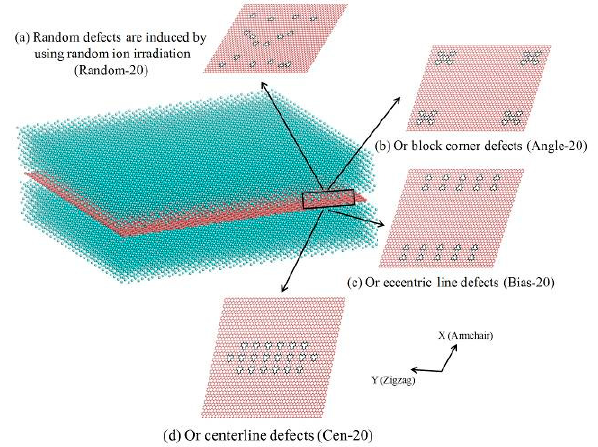
Figure 7. Local side view of graphene with various defects inserted into copper. ( a ) Random defects are induced by 20 randomly ions irradiation. ( b ) Block corner, ( c ) eccentric line, and ( d ) centerline defects are created in graphene by using 20 directional ions irradiation.